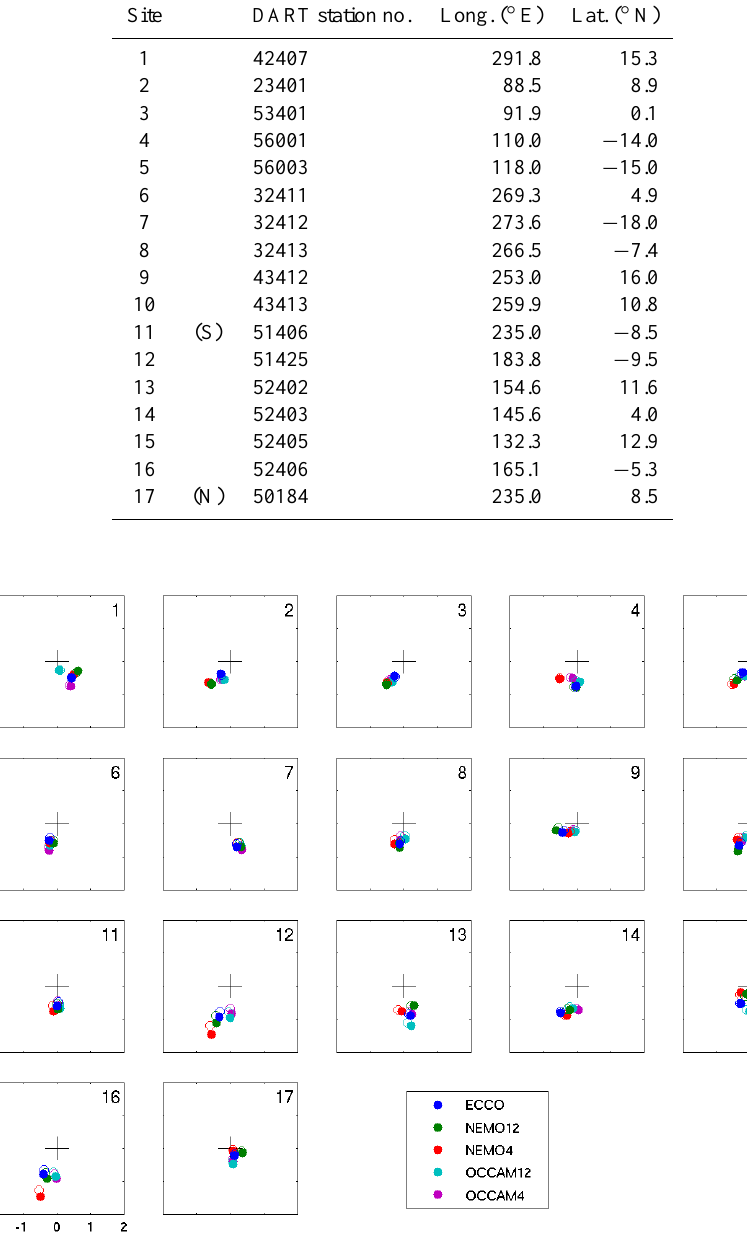
Figure A1. Annual cycles of bottom pressure p dyn from ocean models at each site in mbar. These are calculated over the duration of the model, rather than the available record dates. Open circles are model data, filled circles have SAL effects included. Axes as for Fig.